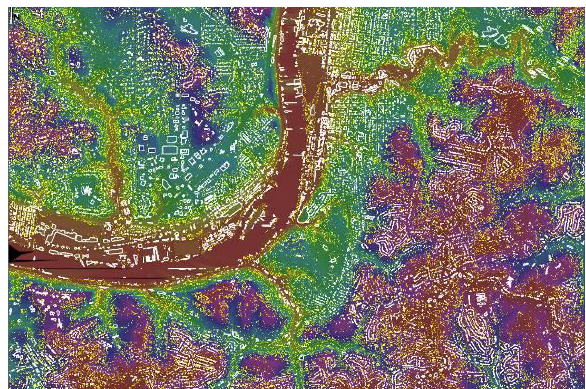
Figure 5. TSR covers 55.7 square kilometers in a mountainous